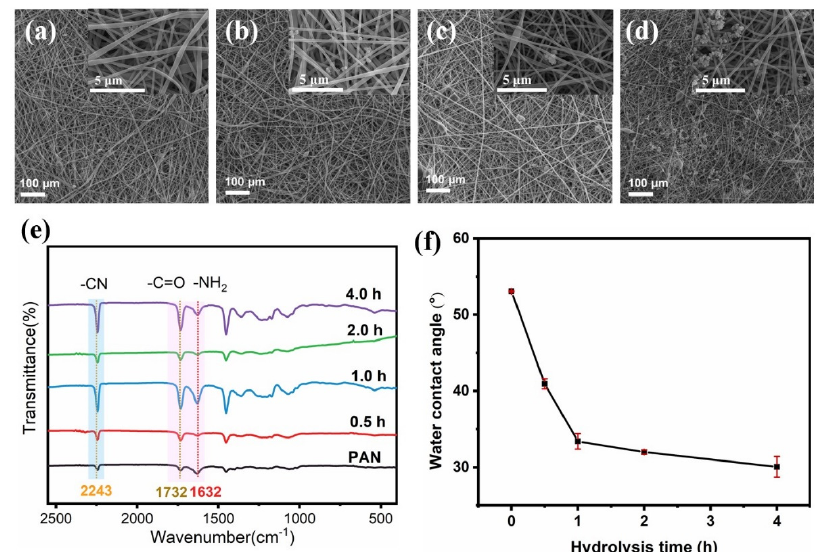
Figure 3. ( a – d ) SEM images of the hydrolyzed PAN with PDA on the surface after polymerization for different times (1, 4, 8, and 20 h, respectively). ( e ) FT-IR spectrum of the nanofiber membranes after different hydrolysis times. ( f ) Water contact angle of the nanofiber membranes prepared at different hydrolysis times.